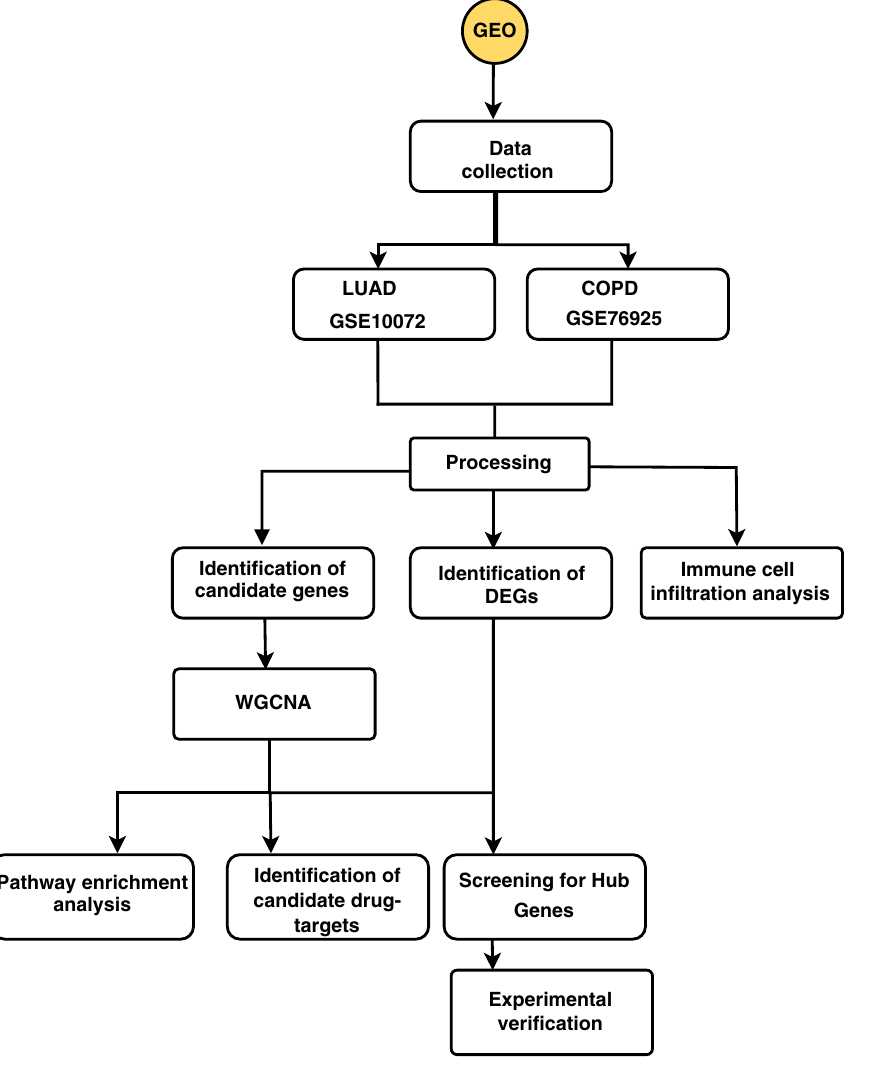
Figure 1. A flowchart showing all the steps involved in our